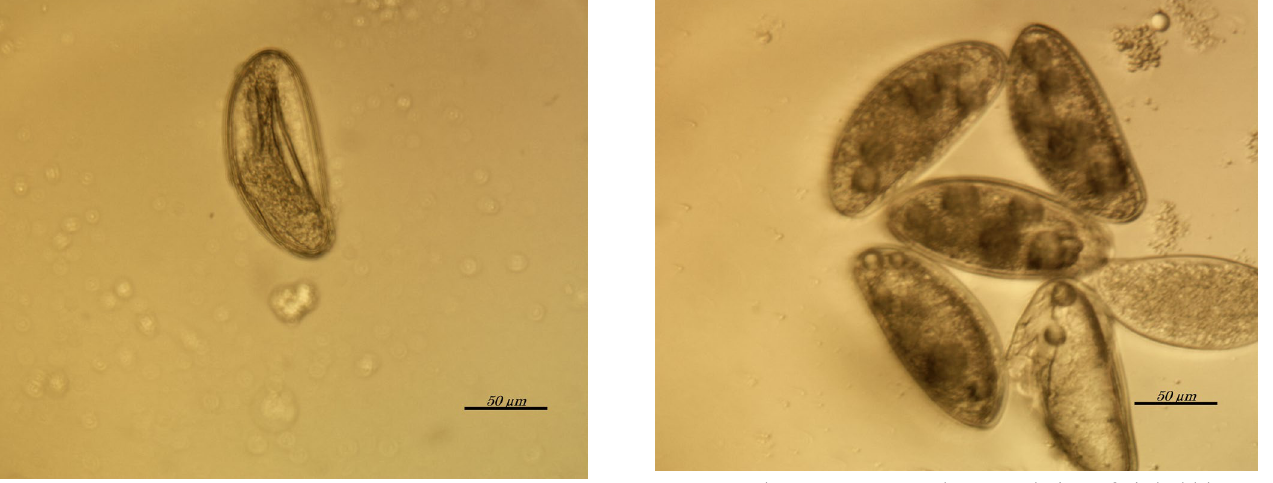
Fig. 3. Resorption of the larva in the egg of Passalurus ambiguus at the stage of its formation using “Virosan”